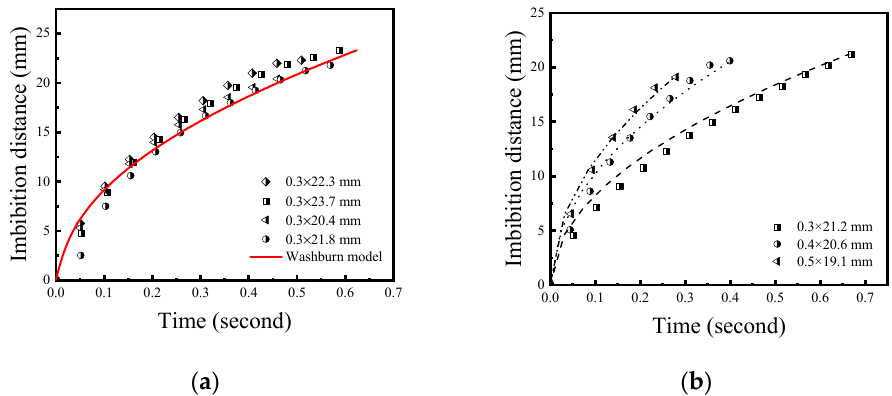
Figure 2. Diagram of the imbibition distance as a function of time in imbibition experiments of liquid-displacing-air in circular single channels. (( a ) shows the experimental results of water-displacing-air, ( b ) shows the experimental results of oil-displacing-air; these curves and point sets represent Washburn model’s prediction curves and the experimental results, respectively).